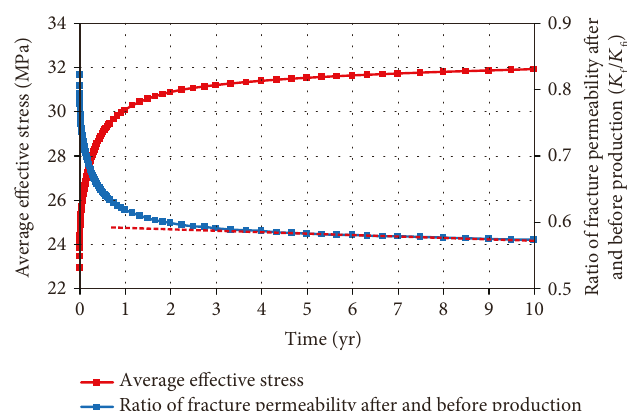
Figure 5: The variation of average e ff ective stress at the well point grid and ratio of fracture permeability after and before production.